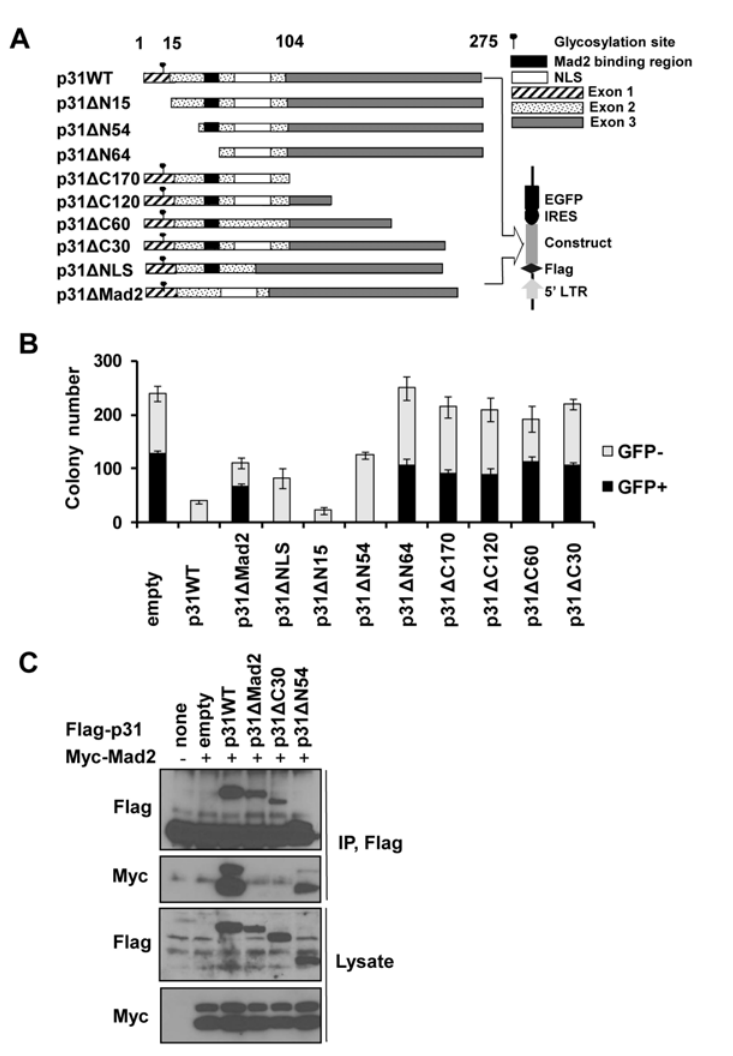
Fig 2. p31 comet -induced cytotoxicity is abolished upon deletion of the C-terminus or the region affecting Mad2 binding. (A) A schematic map of human p31 comet deletion mutants of the N- and C-termini, and regions affecting Mad2 binding and nuclear localization signal (NLS). (B) HeLa cells were infected with retroviruses containing full-length p31 comet or the above deletion constructs and evaluated in terms of colony formation. GFP+ signifies colonies expressing p31 comet . The total represents the sum of GFP-positive and -negative colonies. Values are presented as the mean of triplicate samples. (C) Interactions between